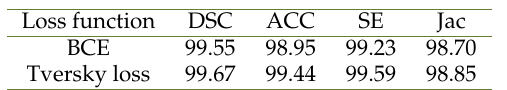
Table 3. Comparison of segmentation results between Table 4. Comparison of segmentation algorithms with